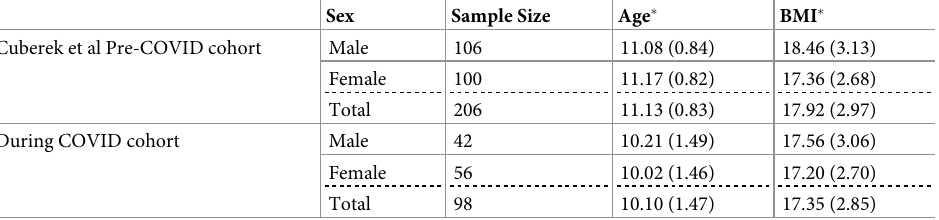
Table 1. Study characteristics comparing Cuberek et al. [38] Pre-COVID data with during COVID data of Czech children. Sex Sample